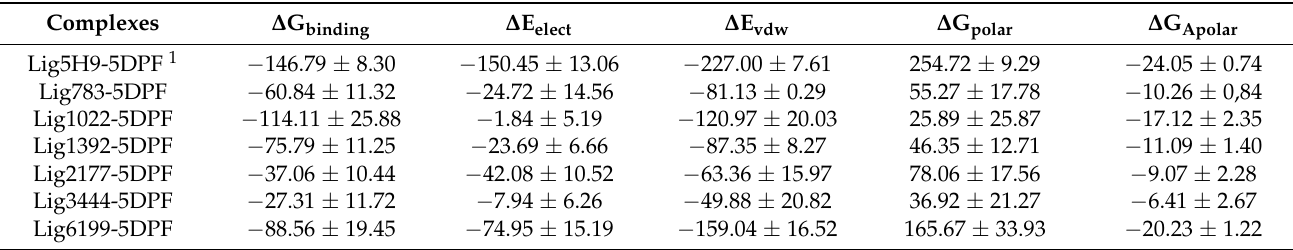
5DPF complex was mainly stabilized via Van der Waals interactions. Table 3. Predicted relative molecular mechanics Poisson-Boltzmann surface area (MM-PBSA) for the free energies (kcal/mol) and individual energy contributions of the complexes taken from 50 ns of trajectories.